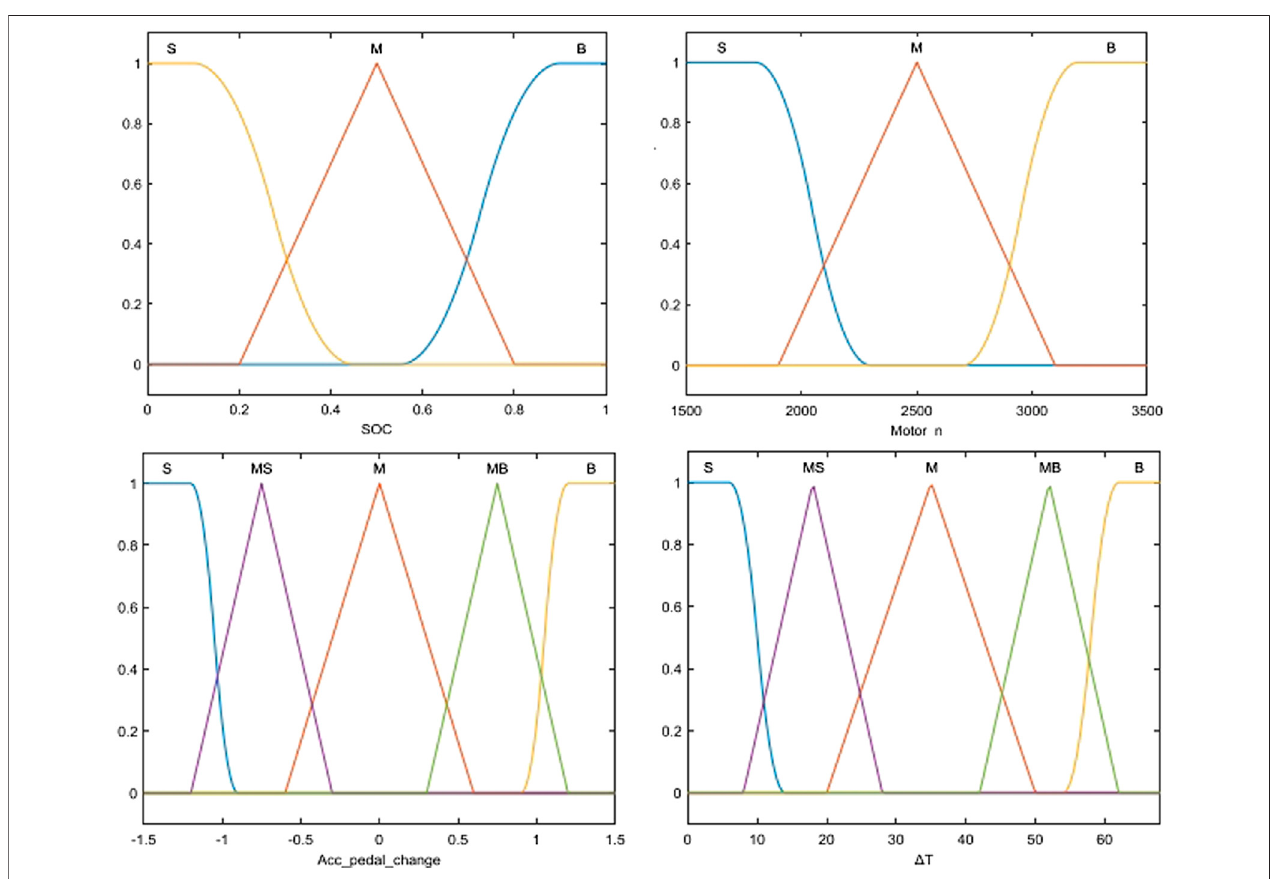
FIGURE 9 | Membership function of input and output variables.